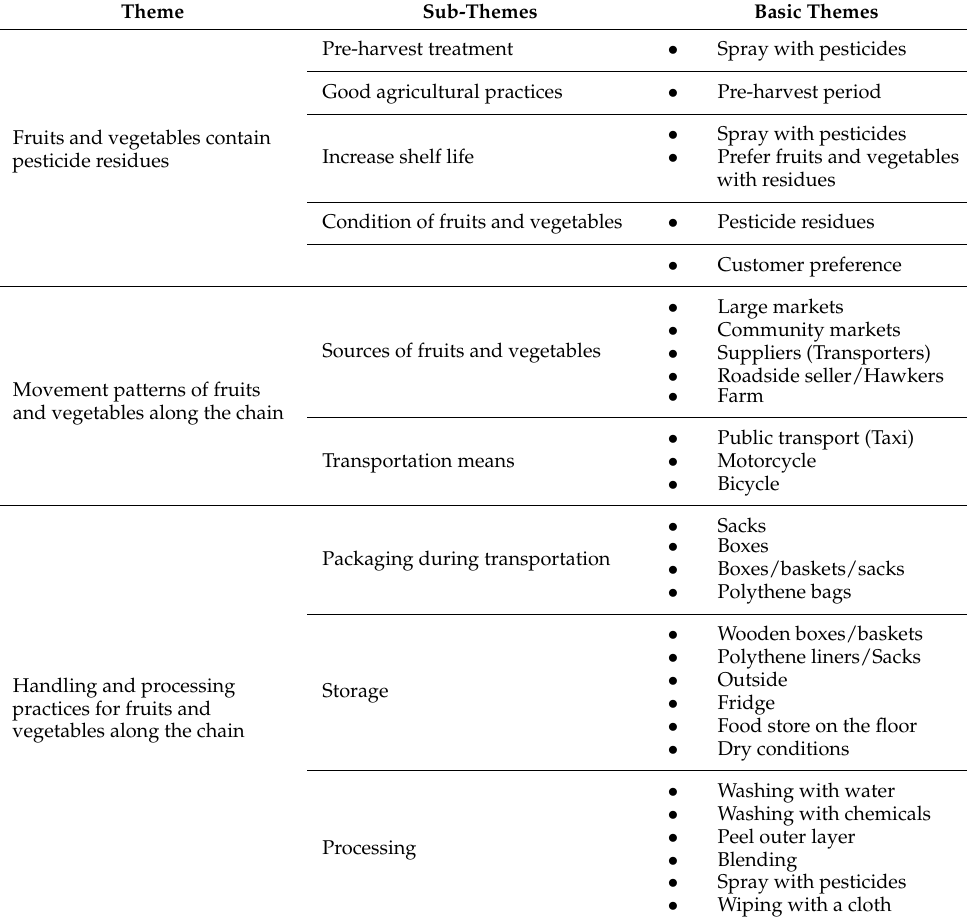
Table 3. Pesticide use practices, movement patterns and handling and process practice of fruits and vegetables from farm to